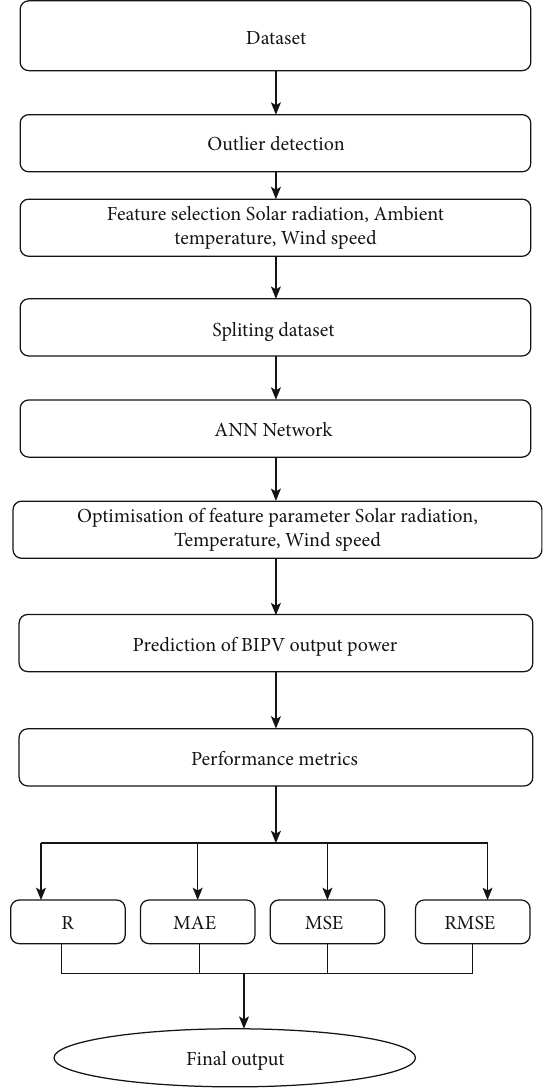
Figure 2: Methodology adopted in the